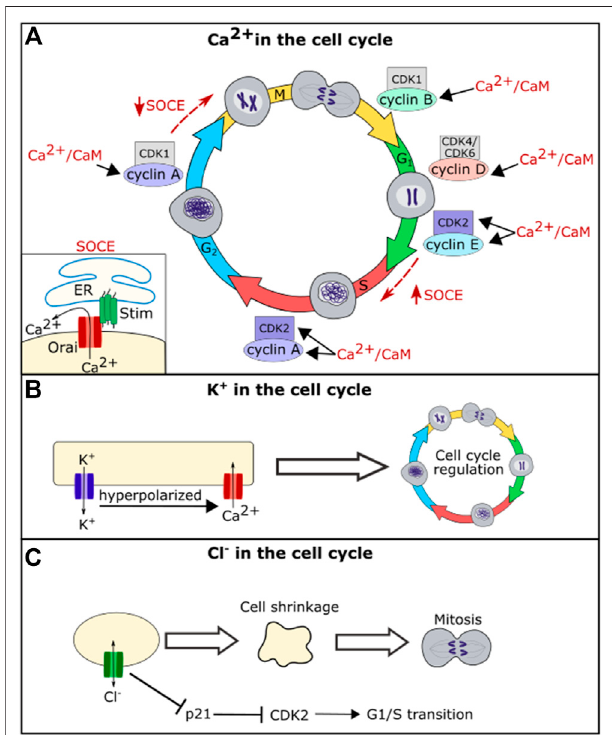
FIGURE3| Schematicdiagramoftheroleofionchannelfunctionincell cycle regulation. Ca 2+ /CaM regulates levels of CDK2, cyclin A, cyclin B, cyclinD,andcyclinE (A) .Calciumfurtherregulatesthecellcyclethroughthe store-operated calcium entry (SOCE) Pathway. SOCE is upregulated at the G1/S phase transition and downregulated at the G2/M phase transition (A) . Potassium fl ux hyperpolarizes the cell, which helps drive calcium into the cell regulating calcium in fl uence on the cell cycle (B) . Chloride fl ux is required for the cell shrinkage that is necessary for mitosis and also regulates levels of p21 (C)